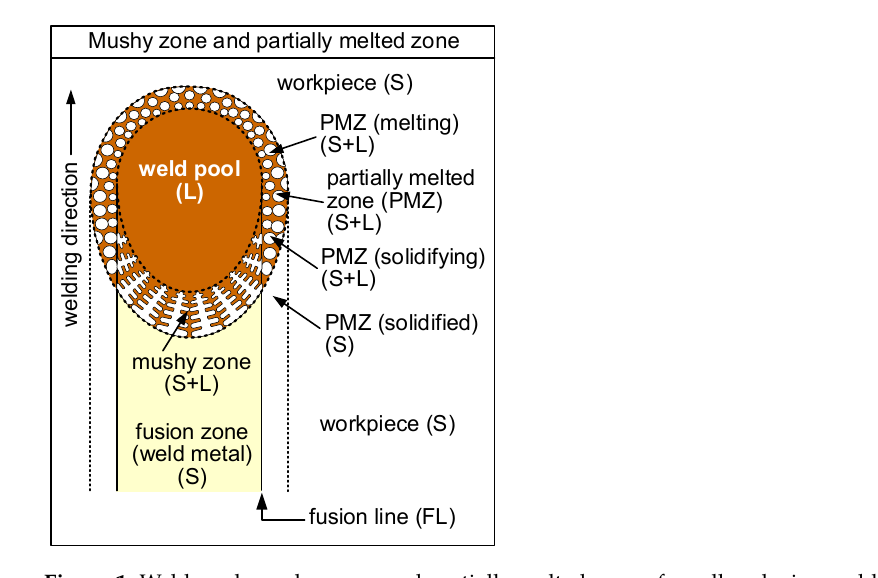
Figure 1. Weld pool, mushy zone, and partially melted zone of an alloy during welding. Regarding liquation cracking in the PMZ, Gittos and Scott [2] welded 6082 Al (Al-0.7 Mg-0.9 Si) with filler metals NG61 (Al-5.2 Mg, close to 5356 Al) and NG21 (Al-5Si, close